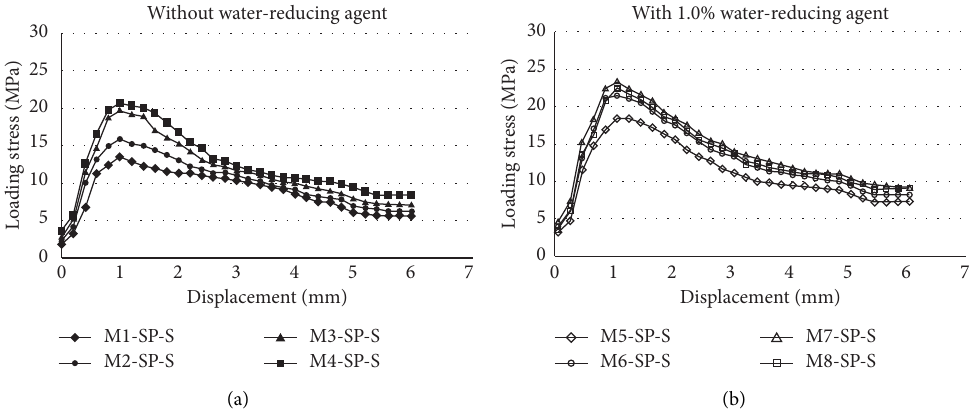
Figure 4: Relationship between loading stress and displacement with smaller specimens: (a) without the water-reducing agent; (b) with 1.0% water-reducing agent.